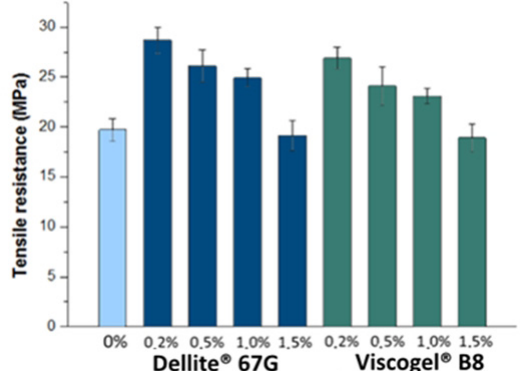
Figure 6. Tensile strength of the dental adhesives containing different percentages of nanofillers